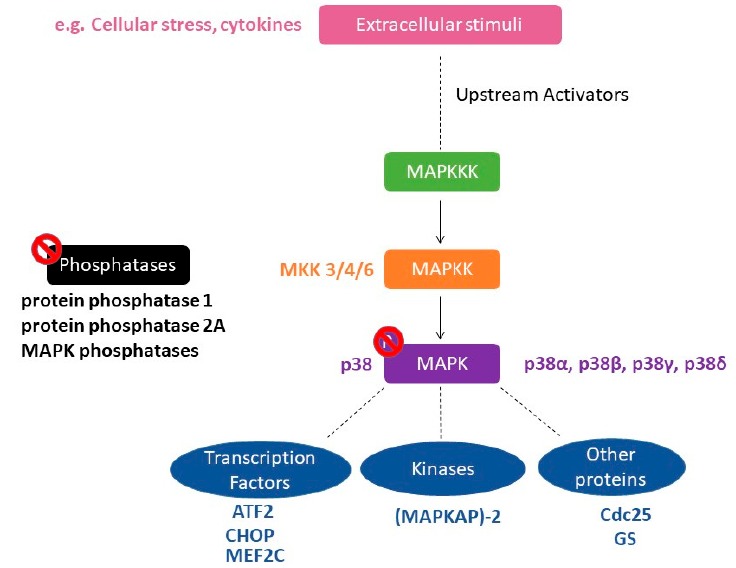
Figure 1. Schematic representation of the p38 mitogen-activated protein kinases (MAPK) signaling pathway. A variety of extracellular signals, such as cellular stress and cytokines, can activate the p38 MAPK pathway. This leads to the initiation of MAPK phosphorylation cascade, in which MAPKKK phosphorylate the p38 MAPK-specific MAPKKs MKK3, MKK4, or MKK6. Subsequently, the four isoforms of p38 MAPK ( α , β , δ , and γ ) are phosphorylated, thereby activating various p38 MAPK substrates. Substrates can be transcription factors such as ATF2, CHOP, and MEF2C, protein kinases such as (MAPKAP)-2 as well as other proteins such as Cdc25 and GS. Phosphorylated substrates go on to elicit varied biological responses. The duration of signaling is controlled by phosphatases such as protein phosphatase 1; protein phosphatase 2A or MAPK phosphatase. Abbreviations: CHOP, CCAAT / enhancer-binding protein-homologous protein; MEF2C, myocyte enhancer factor 2C; (MAPKAP)-2, MAPK-activated protein; GS, Glycogen